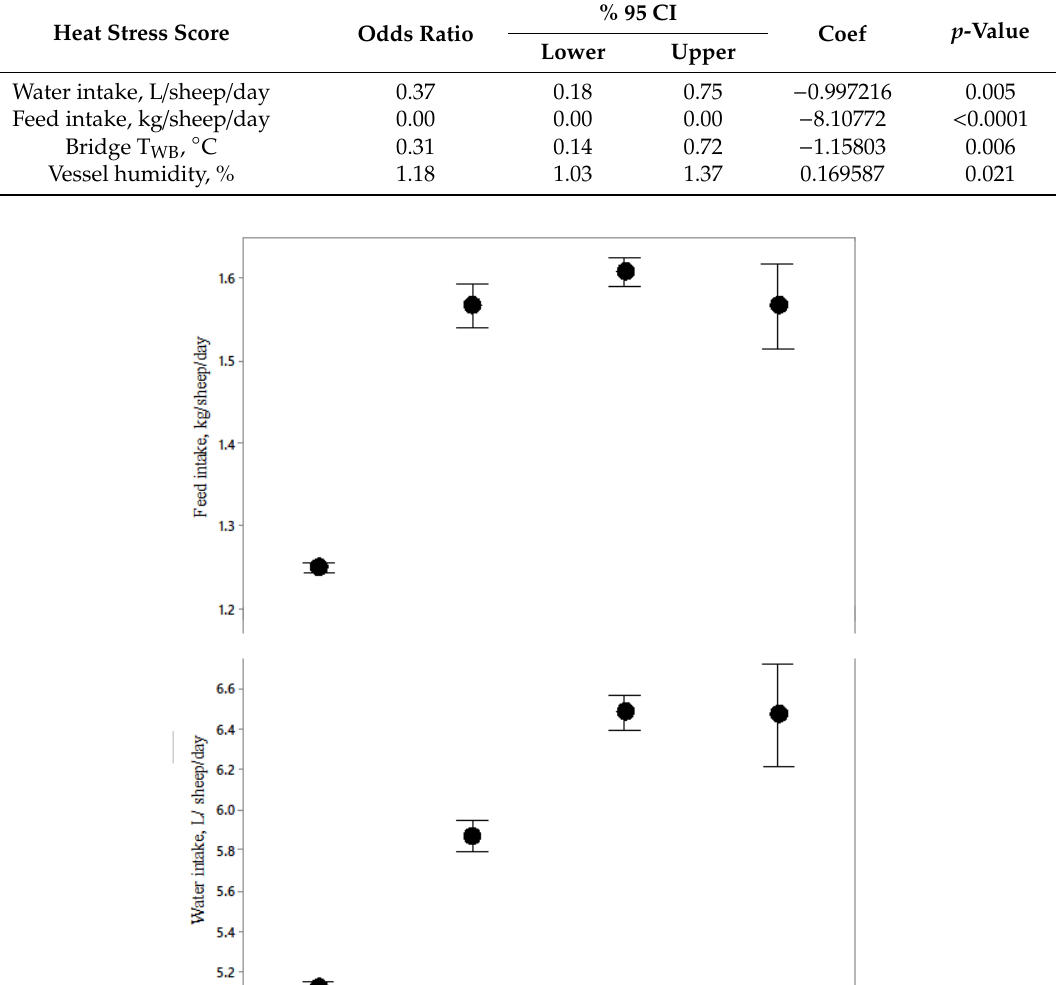
Figure 15. The relationships between feed and water consumption and heat stress score ( n = 3022).